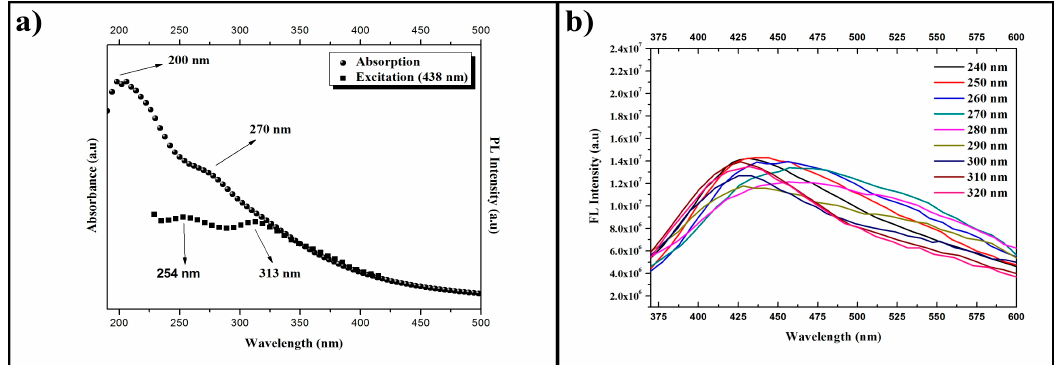
Figure 7. Absorption, excitation, and emission spectra for HSs produced by Route I. ( a ) Absorption curve (spheres) and excitation curve (squares). ( b ) Emission curves (continuous lines) for different excitation wavelengths (increments of 10 nm).